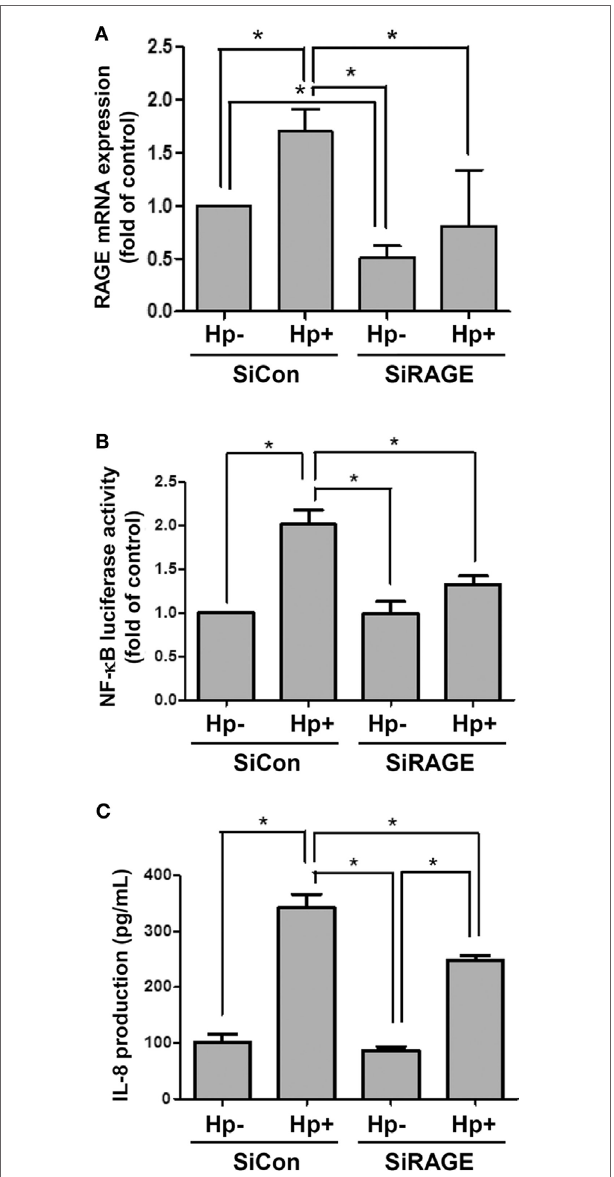
FigUre 5 | Knocking down rage reduces nF- κ B promoter activity and il-8 production in H. pylori -infected ags cells . Cells were transfected with control siRNA (SiCon) or RAGE siRNA (SiRAGE) for 24 h prior to infection with H. pylori (MOI = 100) for 6 h. (a) The RAGE mRNA level was determined by quantitative real-time PCR. (B) Cells were co-transfected with SiRAGE and NF- κ B/wt luciferase reporter for 24 h and cultured with H. pylori (MOI = 100) for an additional 6 h. NF- κ B promoter activity was analyzed by luciferase reporter assay. (c) The level of IL-8 in the culture supernatant was determined using a standard ELISA. Results were expressed as means ± SDs. * P <